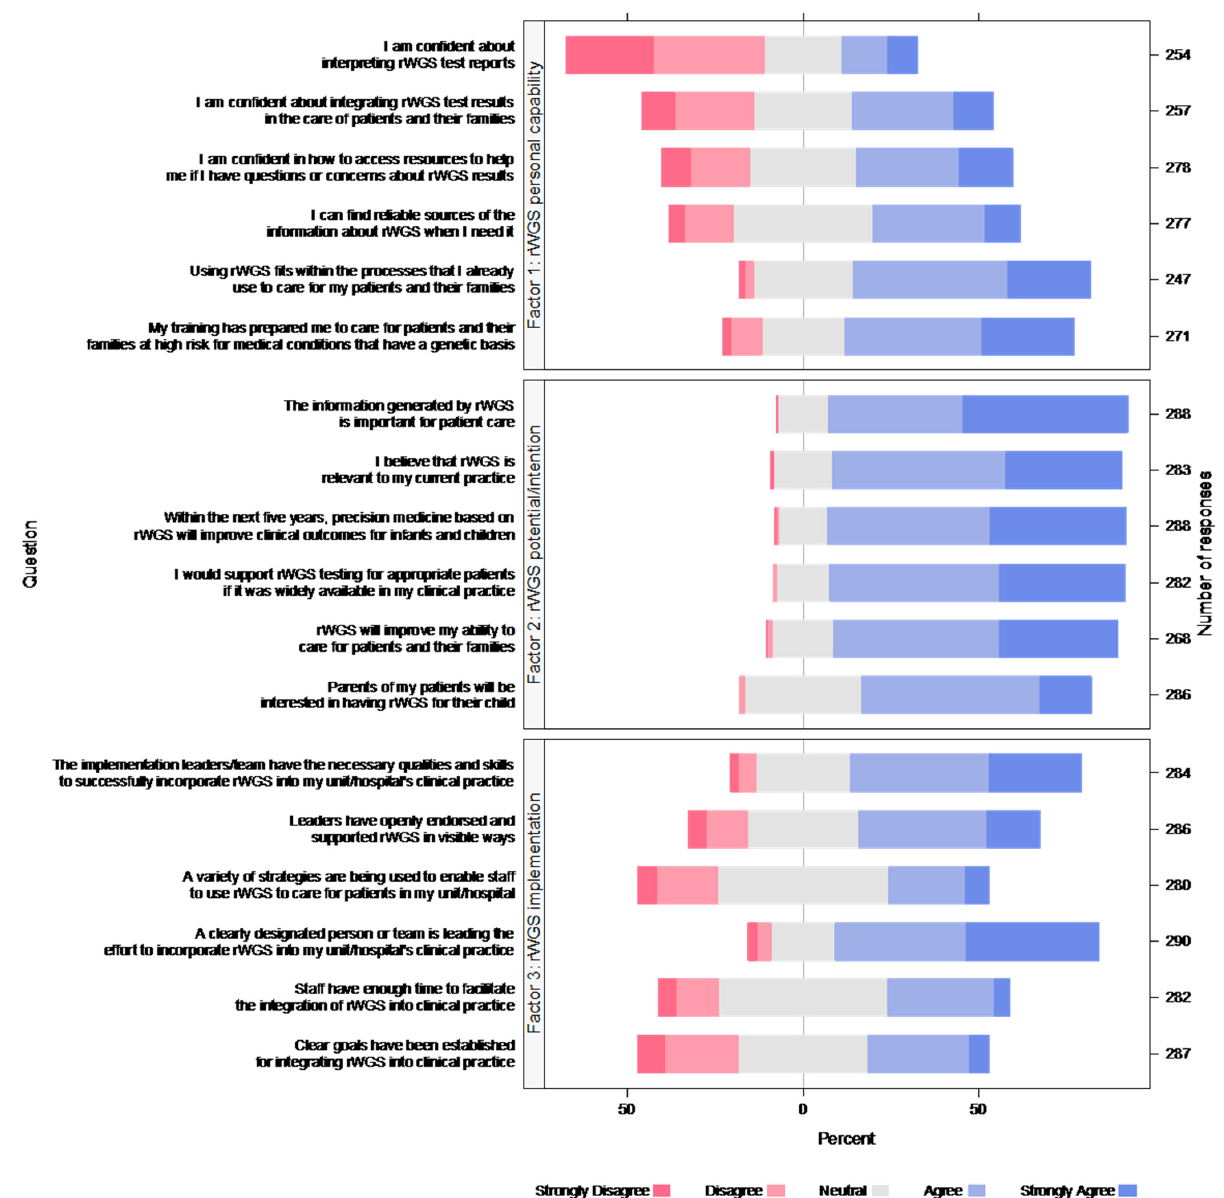
Figure 1. Respondent views about rWGS. Each color bar represents percent of